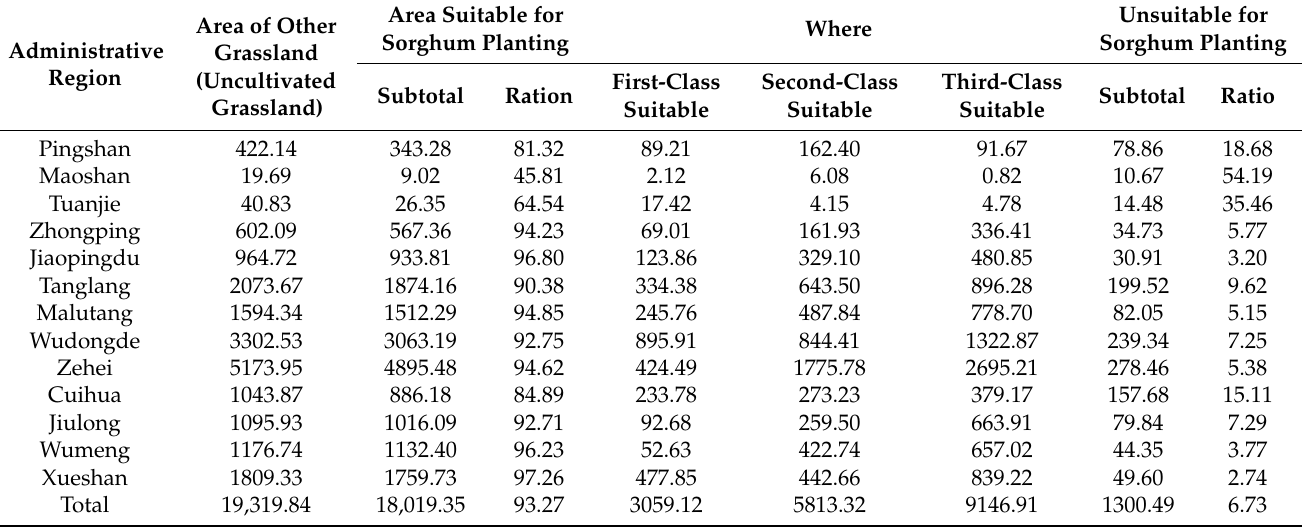
Table 7. Other grassland (uncultivated grassland) area of land suitability grade of sorghum planting in Jinsha River Basin of Luquan County (Unit: ha,